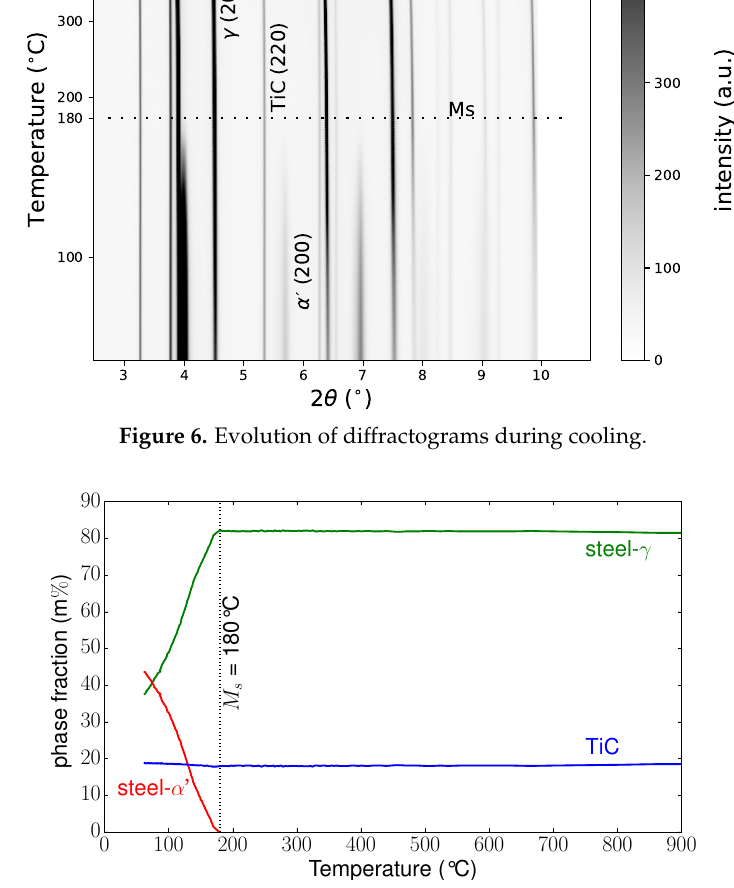
Figure 7. Phase fraction evolutions during